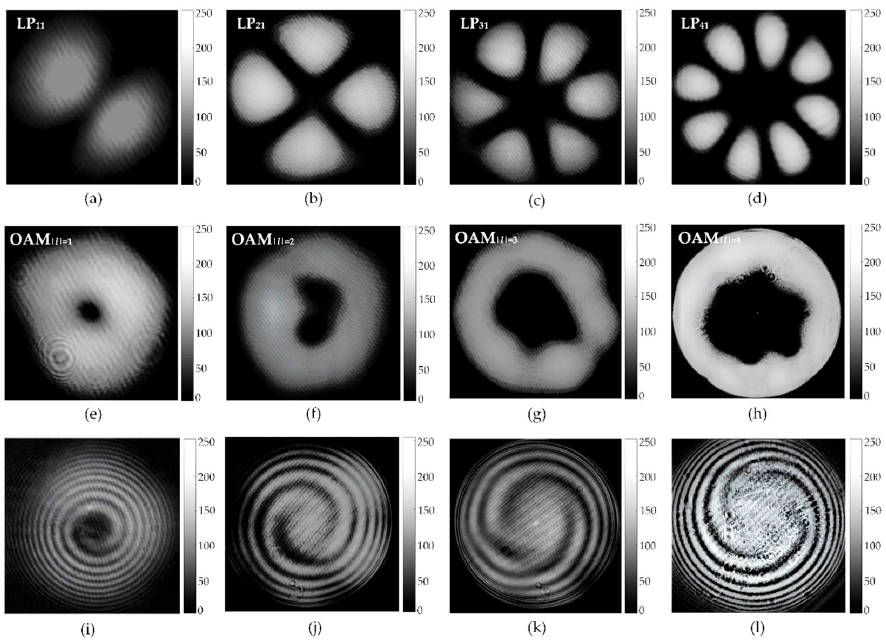
Figure 6. Spiral interferogram and intensity distribution of the OAM mode at 1550 nm: ( a ) Intensity of LP 11 ; ( b ) Intensity of LP 21 ; ( c ) Intensity of LP 31 ; ( d ) Intensity of LP 41 ; ( e ) Intensity of OAM | l |=1 ; ( f ) Intensity of OAM | l |=2 ; ( g ) Intensity of OAM | l |=3 ; ( h ) Intensity of OAM | l |=4 ; ( i ) Interference pattern of OAM | l |=1 ; ( j ) Interference pattern of OAM | l |=2 ; ( k ) Interference pattern of OAM | l |=3 ; ( l ) Interference pattern of OAM | l |=4 .